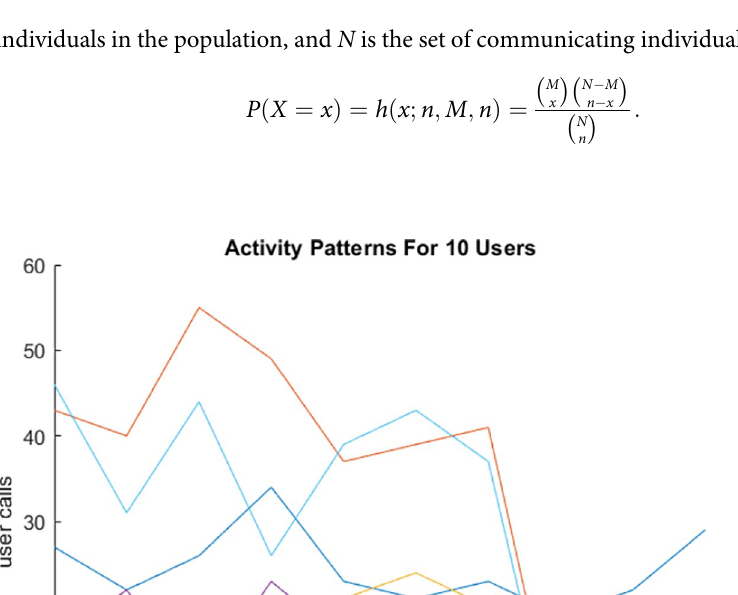
Fig 6. Dataset visualization using MATLAB’s T-SNE function for dimension reduction over Euclidean distance metrics.